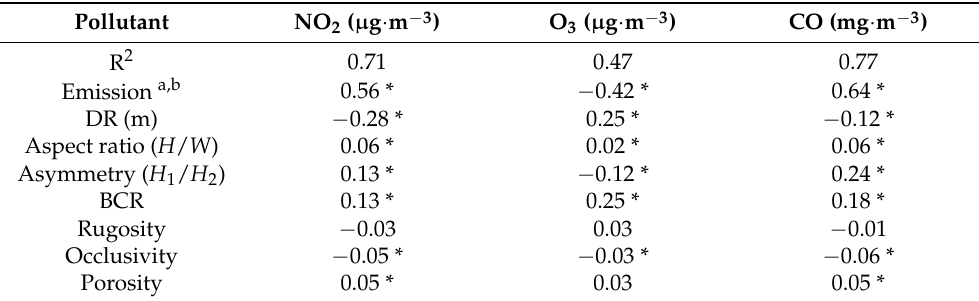
Table 2. Multiple regression coefficients and coefficient of determination (R 2 ) between the time- averaged concentrations of individual pollutants (i.e., NO 2 , O 3 , CO) and eight influencing factors at the ground